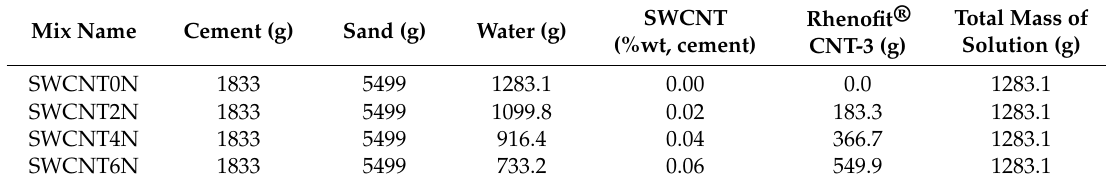
Table 6. Mix design of SWCNT-added mortar without treatment of TX10.